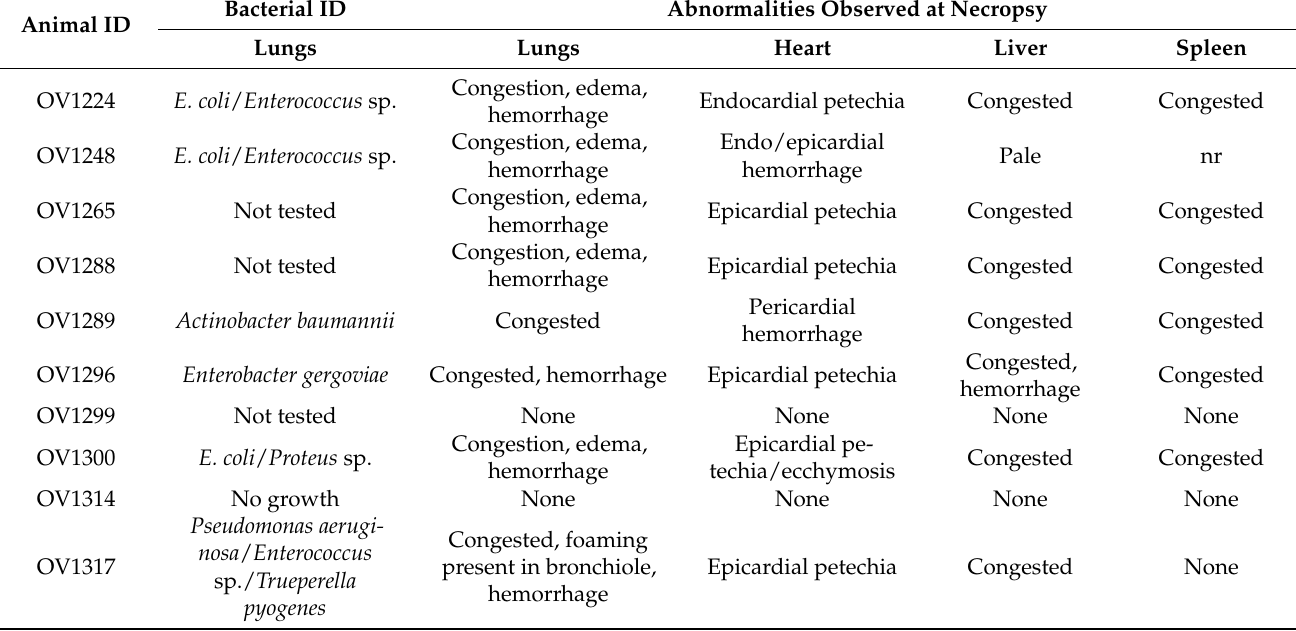
Table 2. Bacteriology and necropsy findings of the 12 farmed white-tailed deer, Florida, U.S. Bacterial ID Abnormalities Observed at Animal ID